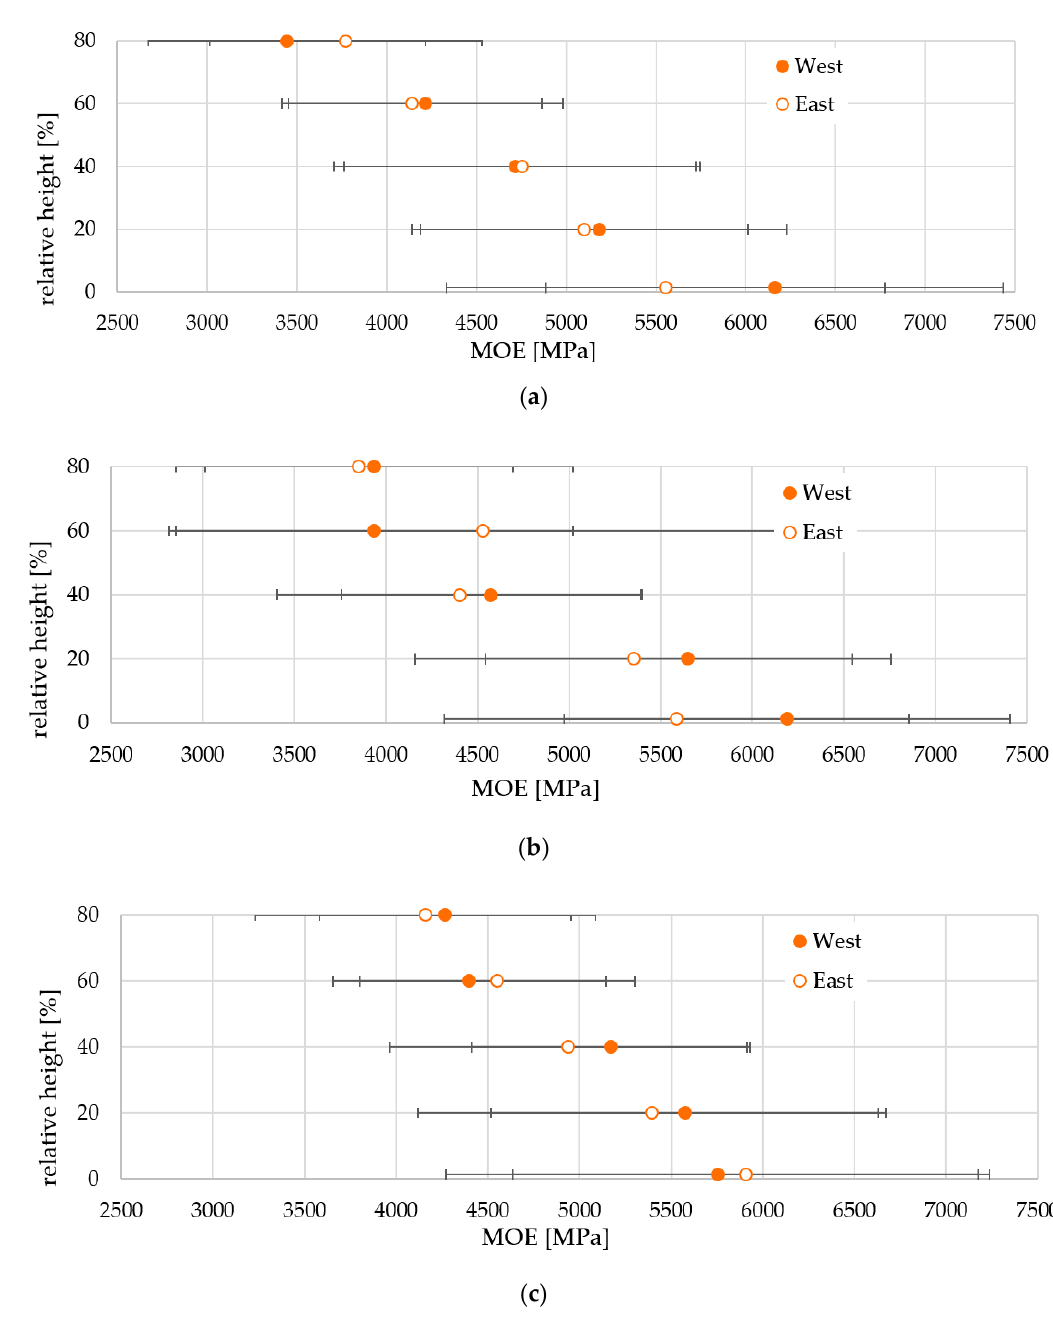
Figure 7. Variability in modulus of elasticity (MOE) along the stem (the lines represented ± standard deviation): ( a ) plot A (0–20 m); ( b ) plot B (30–50 m); ( c ) plot C (60–80 m).